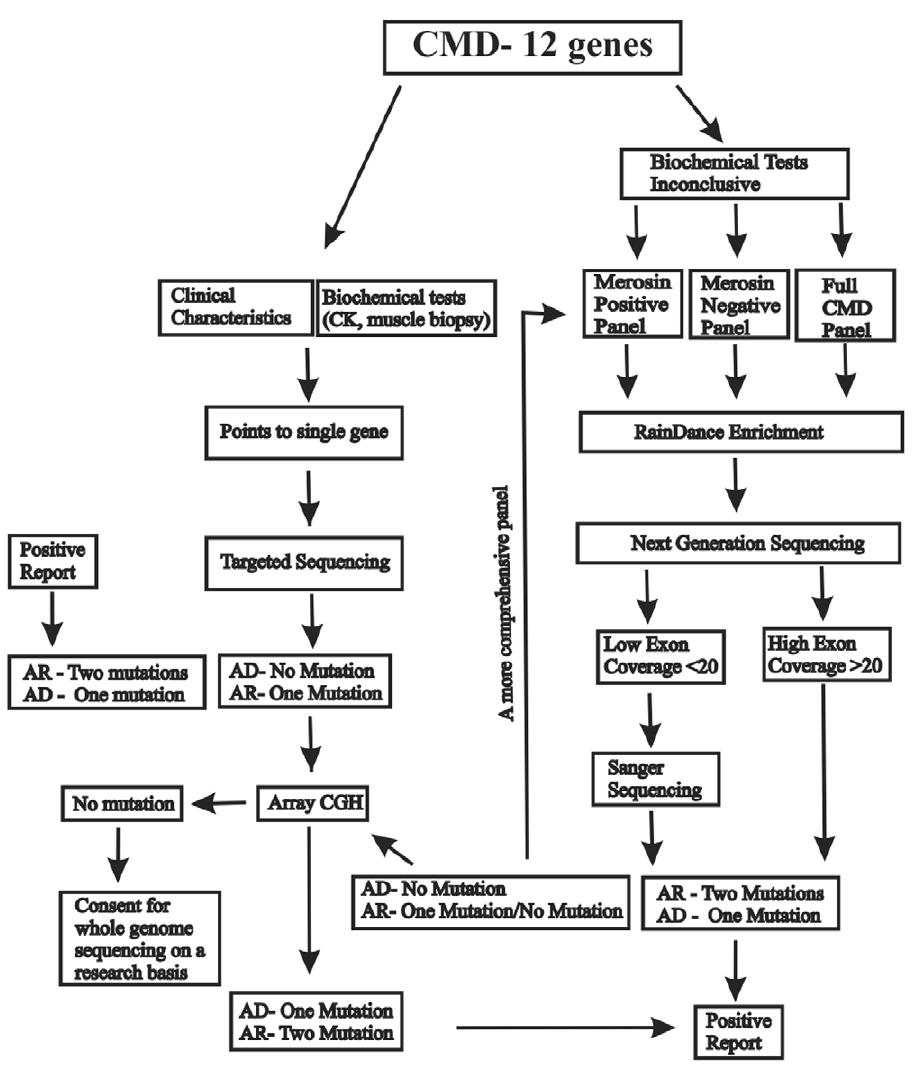
Figure 3. Congenital muscular dystrophy next-generation sequencing algorithm. The diagram demonstrates the diagnostic work-up of congenital muscular dystrophies using RainDance enrichment in combination with next-generation sequencing.